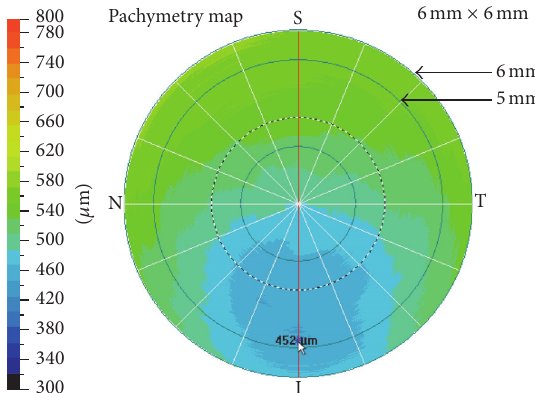
Figure1:ThepachymetrymapinRTVue100isdividedintoacentral circular area (0–2 mm), sixteen pericentral sectors (2–5 mm), and sixteen transitional sectors (5-6 mm). To find the thinnest point in the hypothetical tunnel area, the mouse cursor was slowly dragged along the transitional sectors between the 5-mm and the 6-mm ring. The lowest value found in that area was recorded as the thinnest point (452 𝜇 m in this